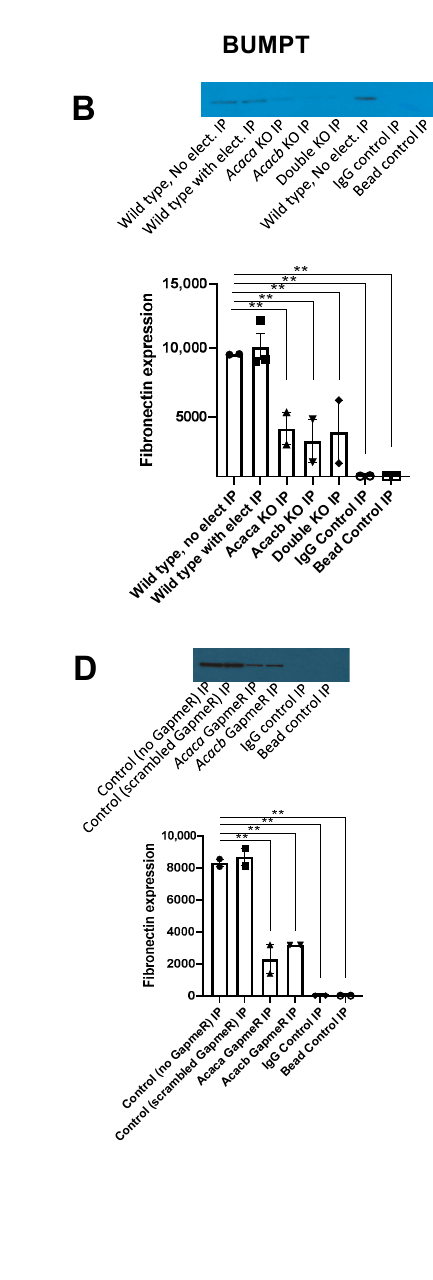
Figure 7. Decreased expression of Fibronectin with ACC blockade. Expression of fibronectin is di ‐ minished by knocking out of ACC1 and 2 encoding genes using CRISPR/Cas9 gene knock out in podocytes ( A ) and BUMPT cells ( B ); by exposure to Acaca and Acacb GapmeRs (2 uM) in podocytes ( C ) and BUMPT cells ( D ); and by exposure to firsocostat (2 uM) in podocytes ( E ) and BUMPT cells ( F ). Positive loading control in panels A and B are wild ‐ type cells with and without electroporation, in panels C and D they are cells exposed to no GapmeR or scrambled GapmeR, and in panels E and